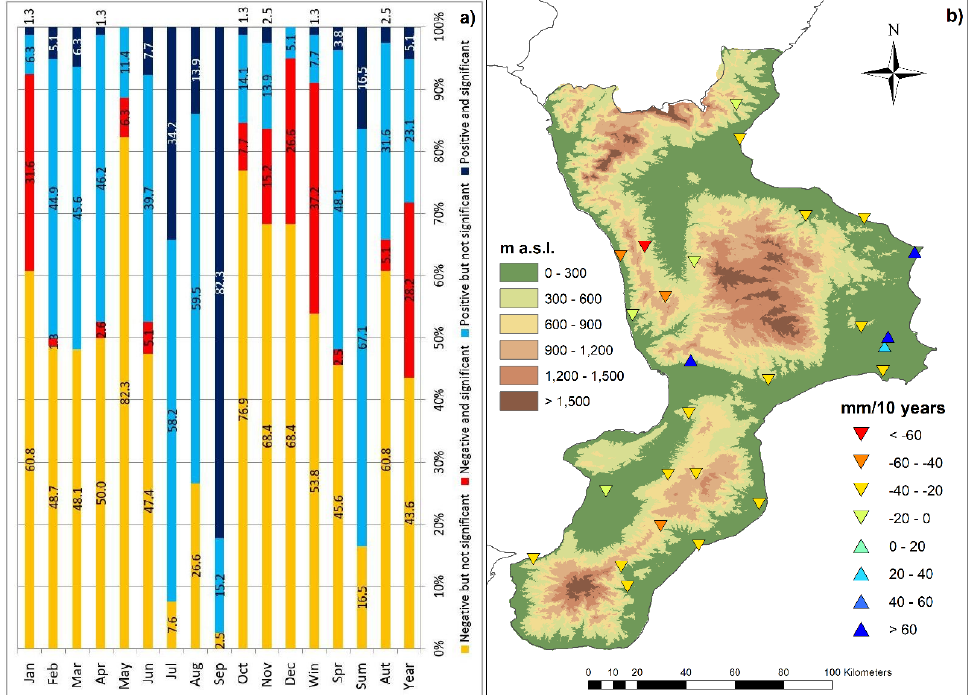
Figure 2. ( a ) The trends of the monthly, seasonal and annual rainfall values expressed as the percentage of rain gauges and ( b ) the spatial distribution of rain gauges showing positive or negative annual rainfall trend.